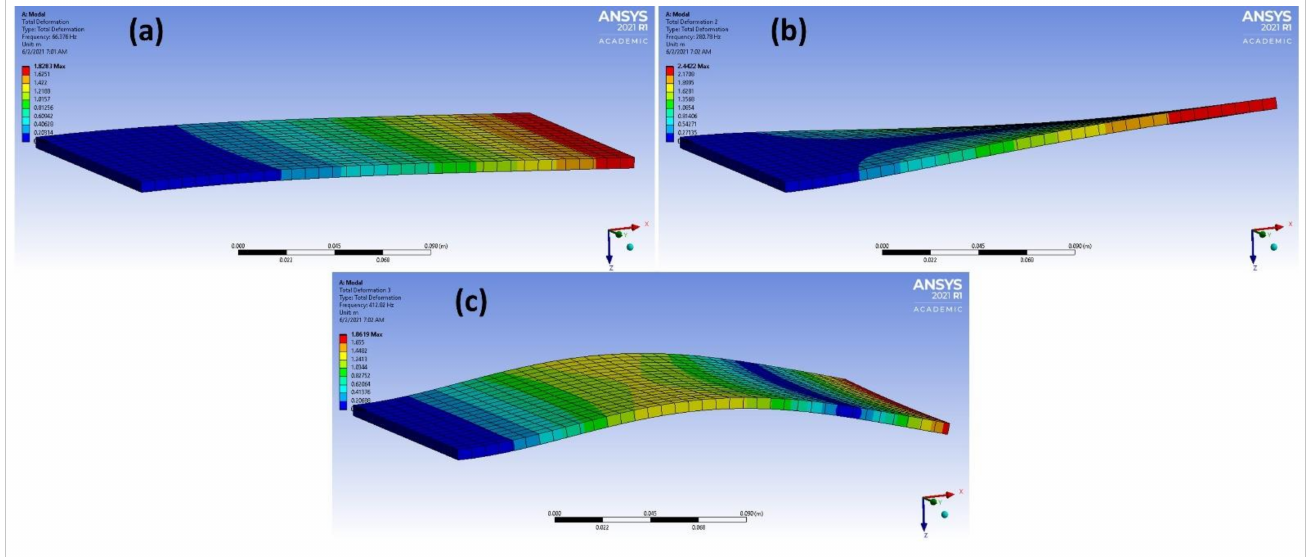
Figure 8. ( a – c ) 3 different mode shapes of steel after data